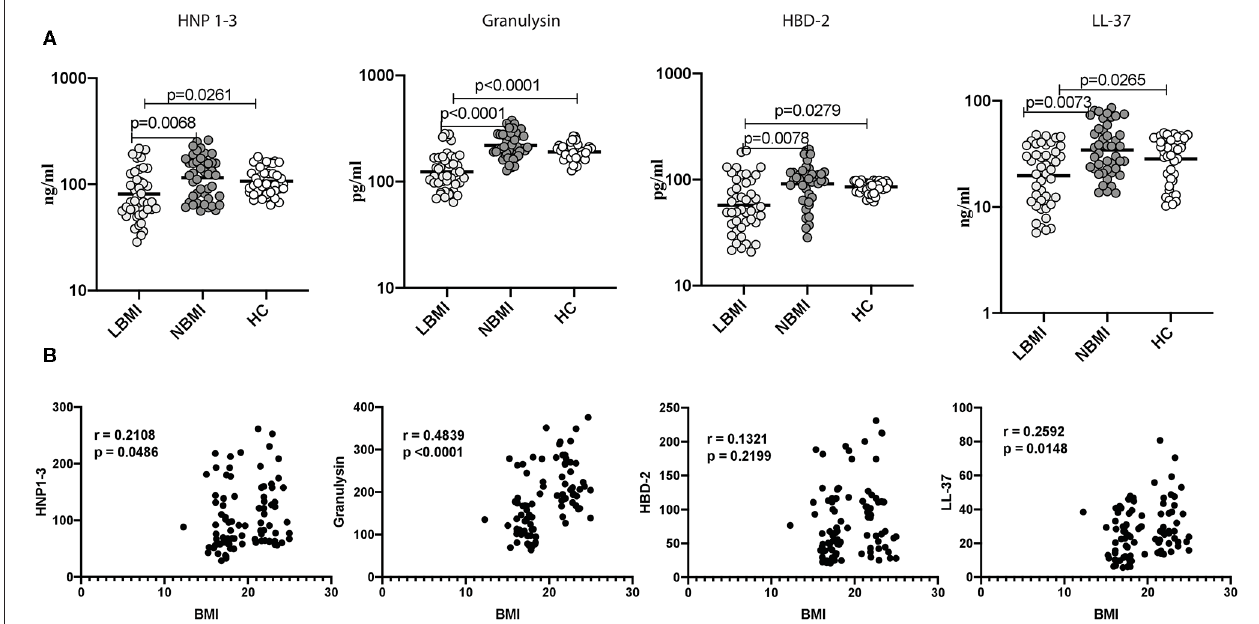
FIGURE 1 | Low BMI is associated with diminished circulating levels of HNP1-3, granulysin, HBD-2 and cathelicidin. (A) The plasma levels of HNP1-3, granulysin, HBD-2, and cathelicidin (LL37) were measured by ELISA in LTBI-LBMI ( n = 44), LTBI-NBMI ( n = 44), and HC ( n = 44) individuals. The data are depicted as scatter plots and each circle represents a single person. (open circle–LTBI with LBMI and light gray–LTBI with NBMI and dark gray- LTBI with HBMI). P -values were calculated using the Kruskal Wallis test with Dunn’s multiple comparison test. (B) Relationship between the levels of HNP1-3, granulysin, HBD-2, and cathelicidin (LL37) and BMI in LTBI individuals. The relationship between the systemic levels of HNP1-3 and granulysin, HBD-2 and cathelicidin (LL37) and BMI were examined in all LTBI ( n = 88) individuals. p and r -values were determined by Spearman rank correlation at 95% confidence